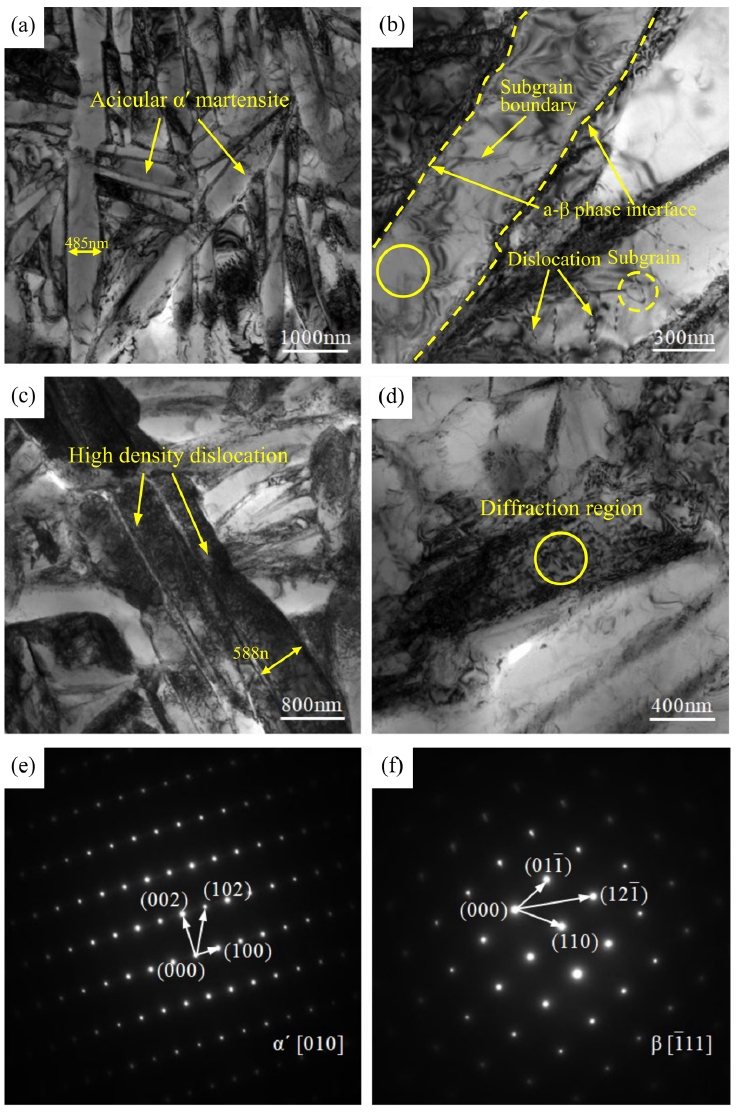
Figure 8. Comparison of the TEM microstructural morphology of the welding joints: ( a , b ) flux-cored wire; ( c , d ) cable wire; ( e ) diffraction spots of the α phase; ( f ) diffraction spots of the β phase.